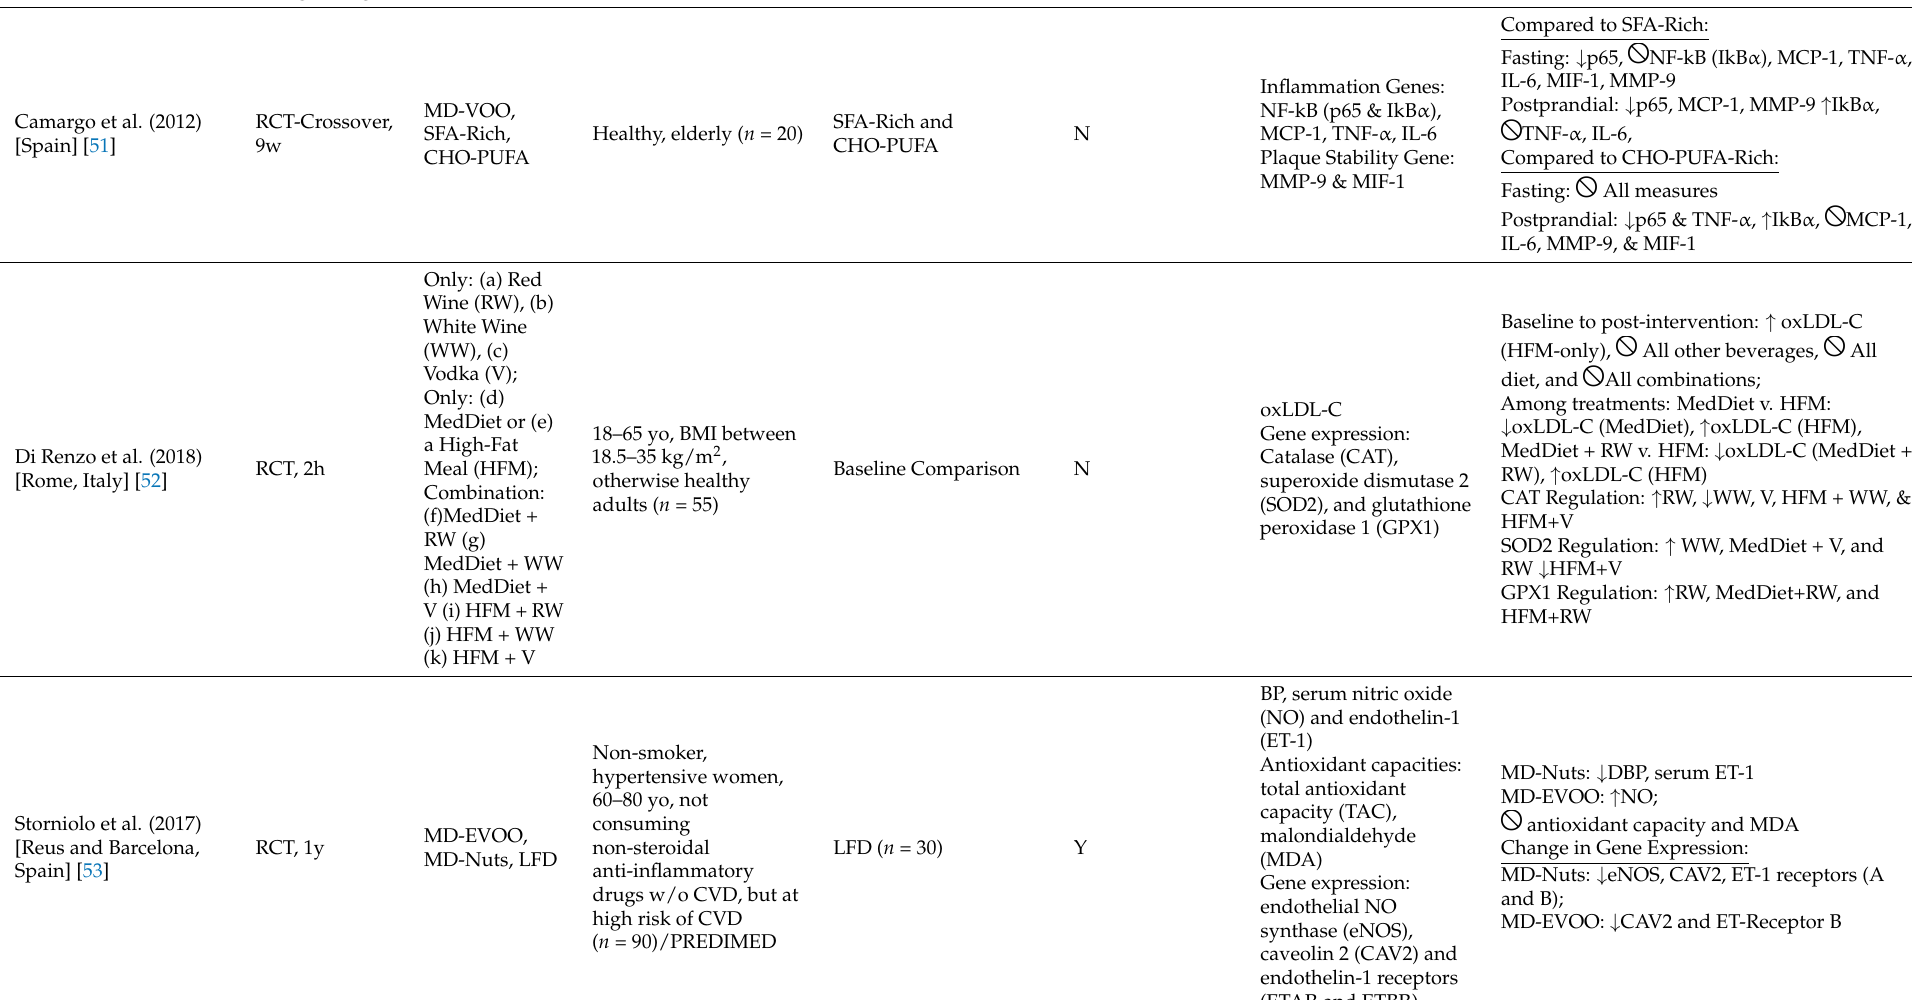
Table 2. Clinical Studies.